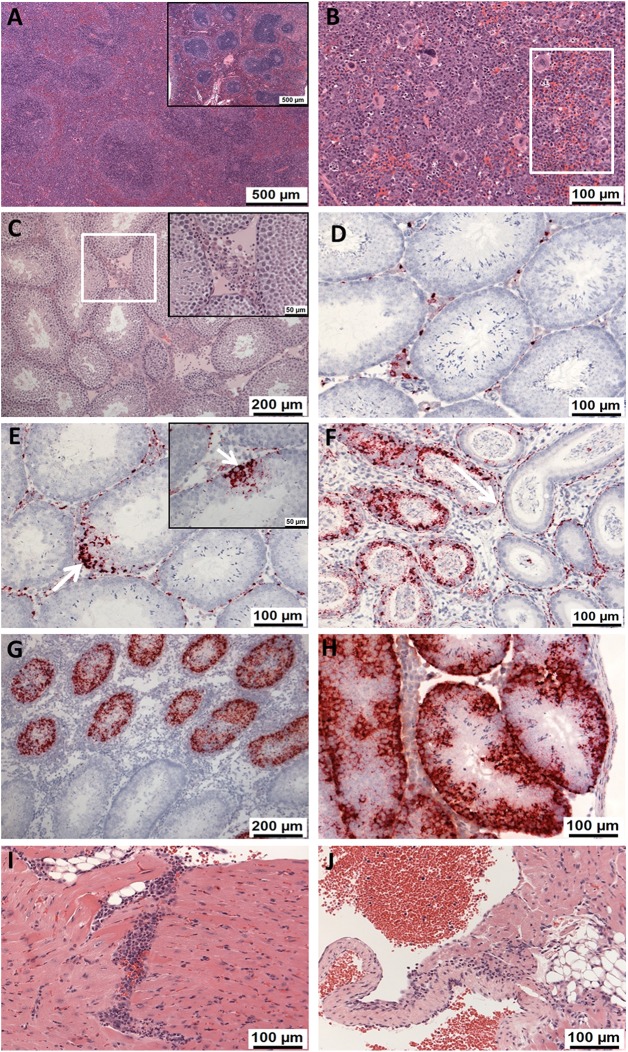
Histological and RNA in situ hybridisation findings in the spleen, testes and heart of ZIKV-challenge A129 mice.(A) Spleen. Poorly defined areas comprising large mononuclear cells within the white pulp (Animal 86783, 106 pfu ZIKVAF, day 5). Inset, normal spleen with well defined, small germinal centres within the white pulp (Animal 86739, unchallenged). (B) Spleen. Prominent, extra-medullary haematopoiesis in the red pulp. Rectangle, numerous PMNs in the red pulp sinuses (Animal 86724, 106 pfu ZIKVAF, day 7). (C) Testis. Expansion of the interstitial tissue by proteinaceous fluid, macrophages and PMNs. Inset, higher power image of area within white square (Animal 86772, 10 pfu ZIKVAF, day 5). (D) Testis. Mild infiltration of PMNs into the interstitial space with positive viral staining (Animal 86779, 106 ZIKVAF, day 3). (E) Testis. Positive staining of virally infected cells focally within the walls of the seminiferous tubules (white arrows) as well as within the interstitium (Animal 86784, 10 pfu ZIKVAF, day 7). (F) Testis. Epididymis with positive staining of cells in lumen and epithelium of the efferent ductules as well as the interstitium (Animal 86784, 10 pfu ZIKVAF, day 7). (G) Testis. Positive staining of cells in the necrotic seminiferous tubules (Animal 86744, 106 pfu ZIKVAS, day 14). (H) Testis. Intra-tubular and interstitial cell staining (Animal 86757, 106 pfu ZIKVAS, day 7). (I) Heart. Infiltration of myocardium by macrophages and PMNs (Animal 86779, 106 ZIKVAF, day 3). (J) Heart. Infiltration of an atrio-ventricular valve by macrophages and PMNs (Animal 86780, 106 pfu ZIKVAF, day 3). A-C and I-J show sections stained with haematoxylin and eosin (H&E) and D-H show RNA in situ hybridisation images.